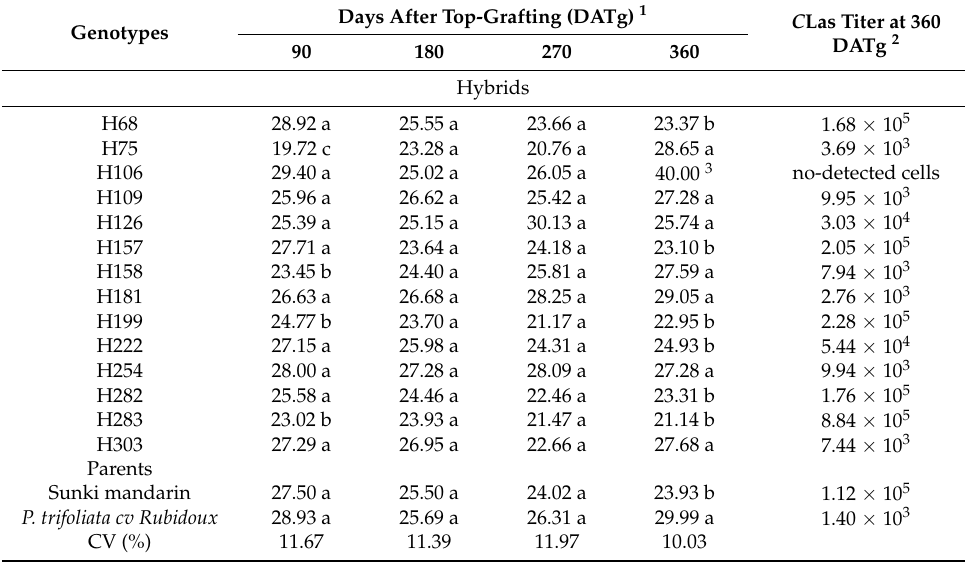
Table 3. C T values and concentrations of Candidatus Liberibacter asiaticus ( C Las) in citrandarins. Plants were analyzed for 12 months and a decrease in the number of replicates positive for C Las infection was observed over